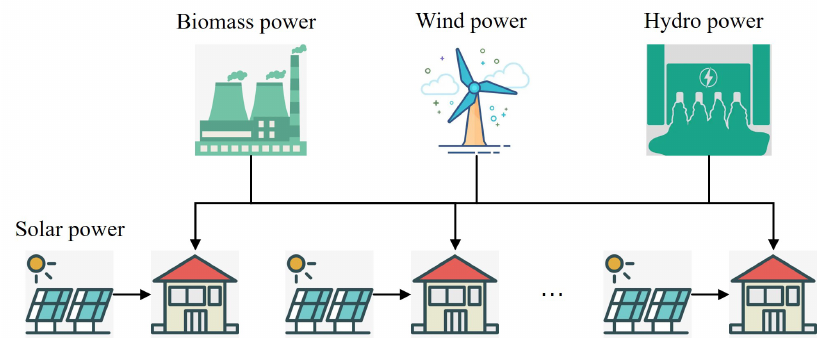
Figure 1. Structure of residential energy